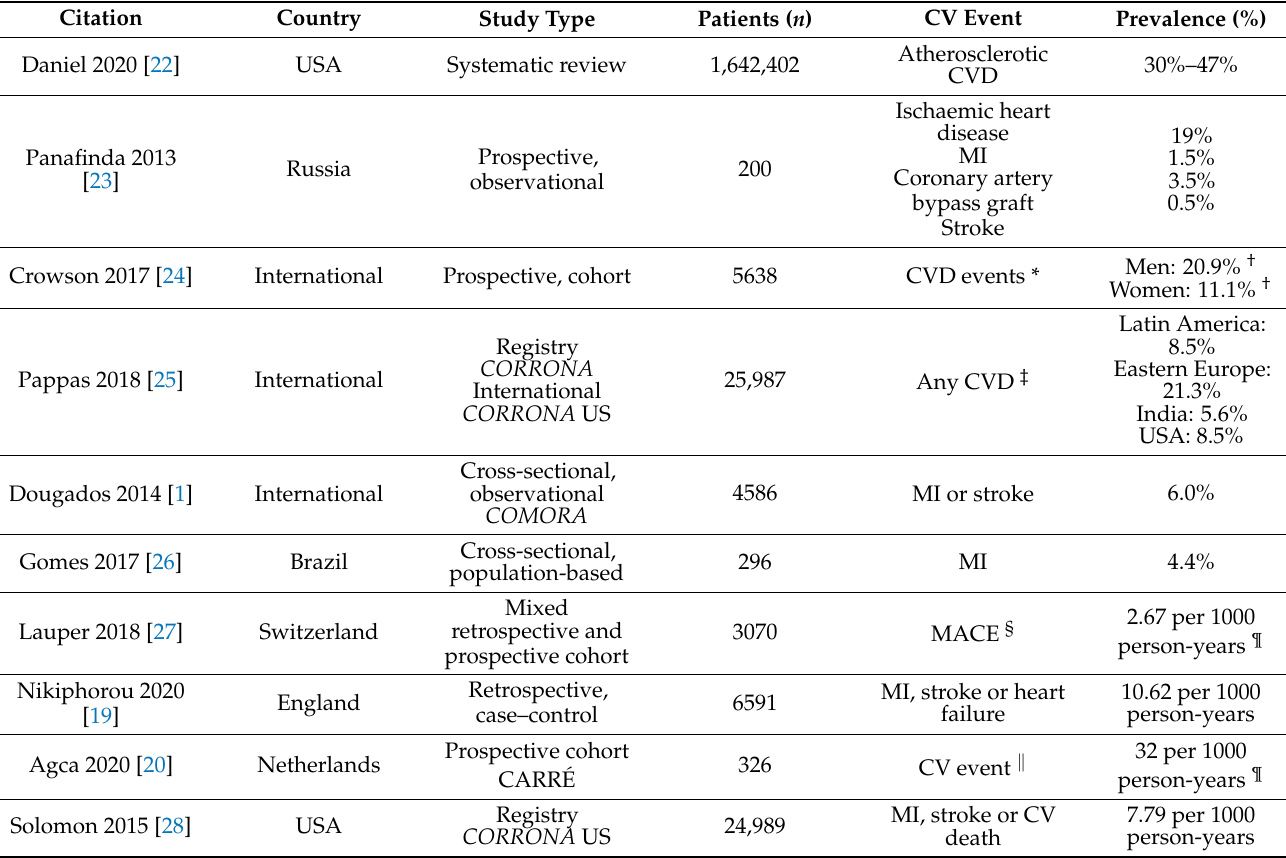
Table 1. Prevalence of cardiovascular disease in patients with rheumatoid